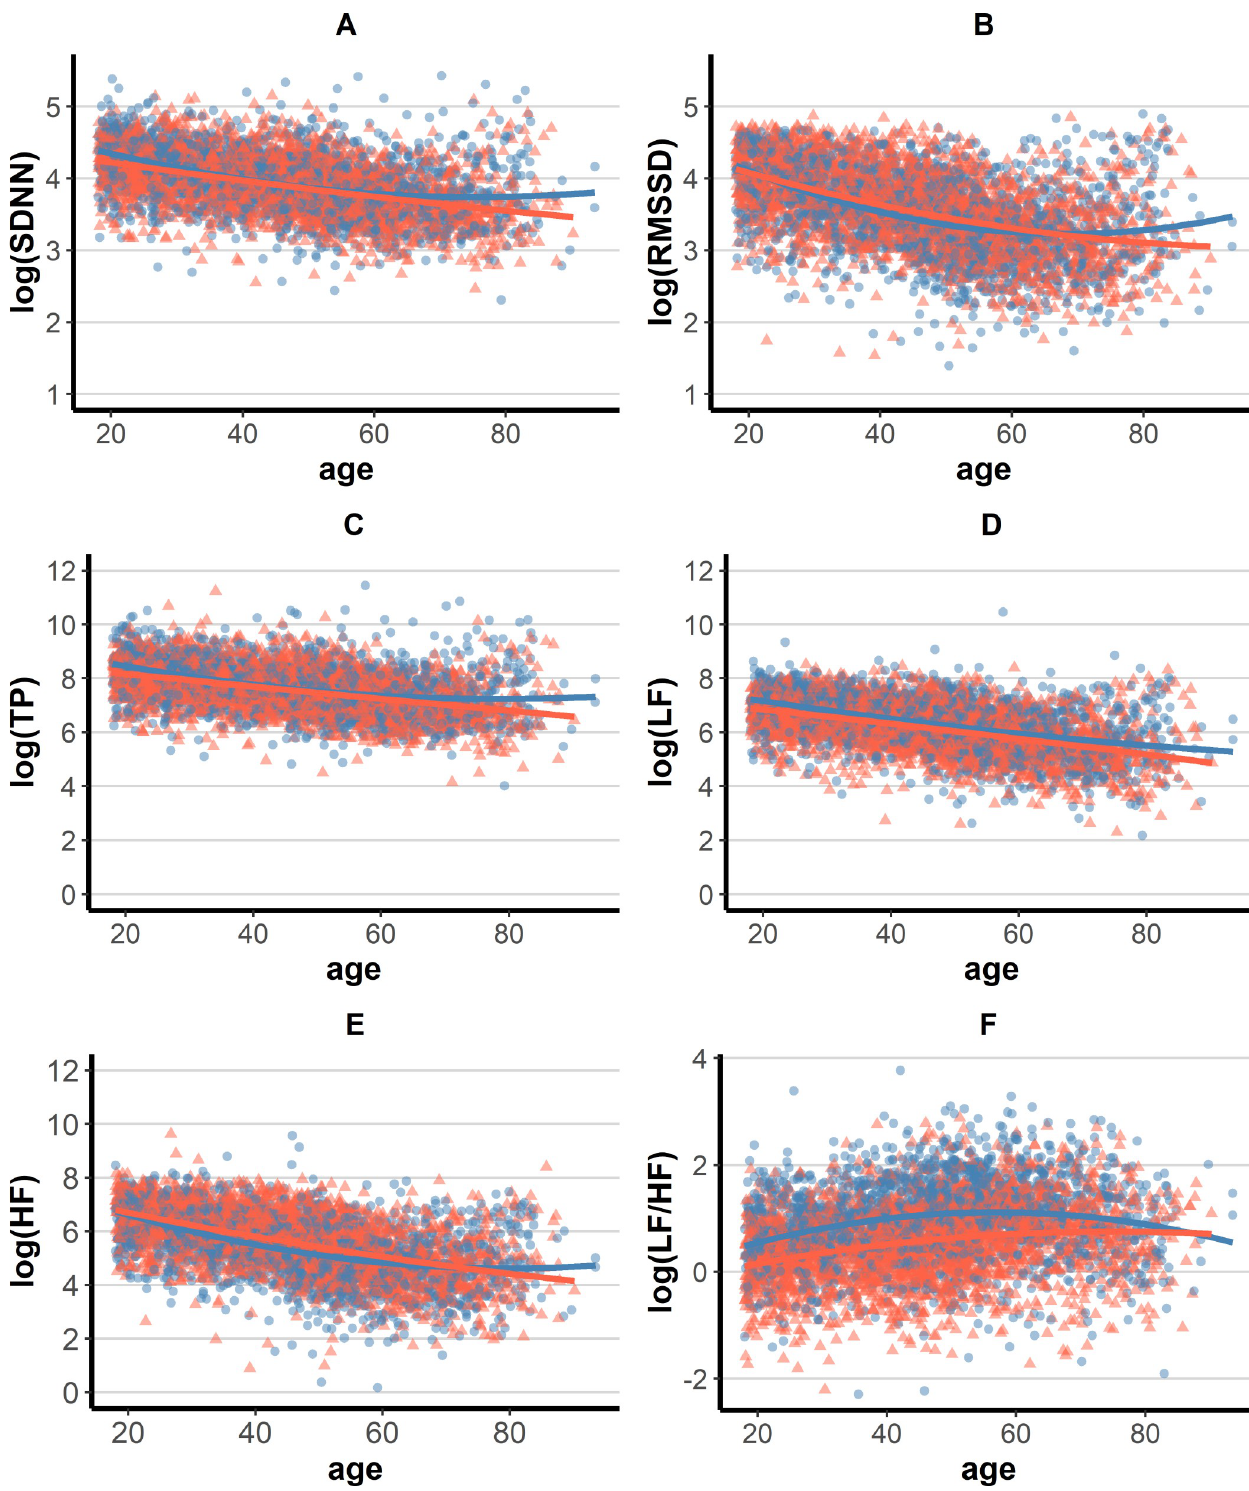
Fig 1. Distribution of HRV indexes by age and sex. Blue: males; red: females. Fitting lines were based on loess quadratic smoothing ( A ) log(SDNN); ( B ) log (RMSSD); ( C ) log(TP); ( D ) log(LF); ( E ) log(HF); and ( F ) log(LF/HF). Measurement units: SDNN and RMSSD are expressed in ms; TP, LF, and HF in ms 2 .